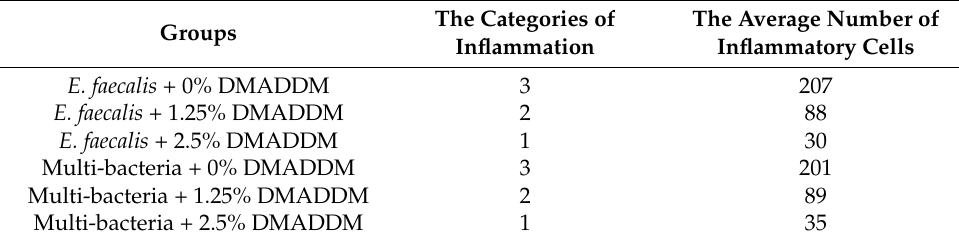
Figure 3. The volume and histopathological section of periapical lesions treated by DMADDM. ( a ) Change of apical shadow volume after treatment with DMADDM. “E” represents E. faecalis , “M” represents multi-bacteria, “D” represents DMADDM; ( b ) histopathological images after treatment with DMADDM. Chronic inflammatory reaction (INF) in the apical periodontal space, neovascularization (NV) around areas of apical resorption, and neoformed cementum (NC) partially repaired areas of apical resorption. The apical shadow volume was tested through CBCT and calculated by MIMICS V21.0. Each value is mean ± SD ( n = 6) (* p < 0.05, ** p < 0.01, *** p < 0.001). Table 2. The histopathologic results after treatment with